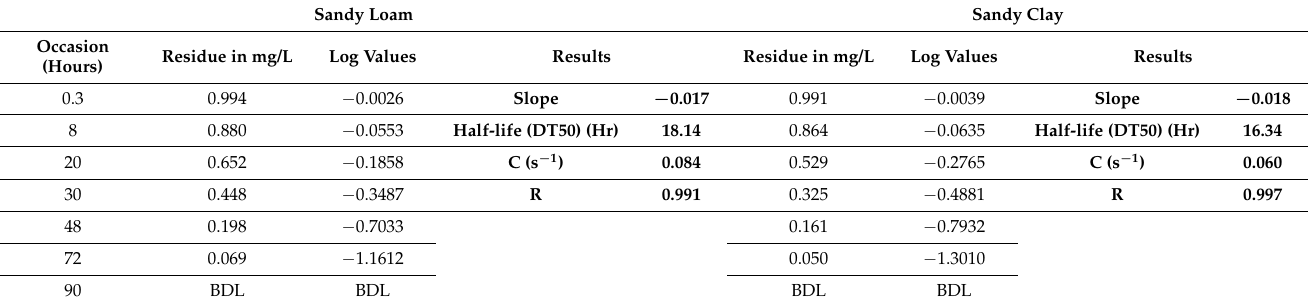
Table 9. Kinetic parameters for difenoconazole photocatalytic remediation in soil under sunlight. Sandy Loam Sandy